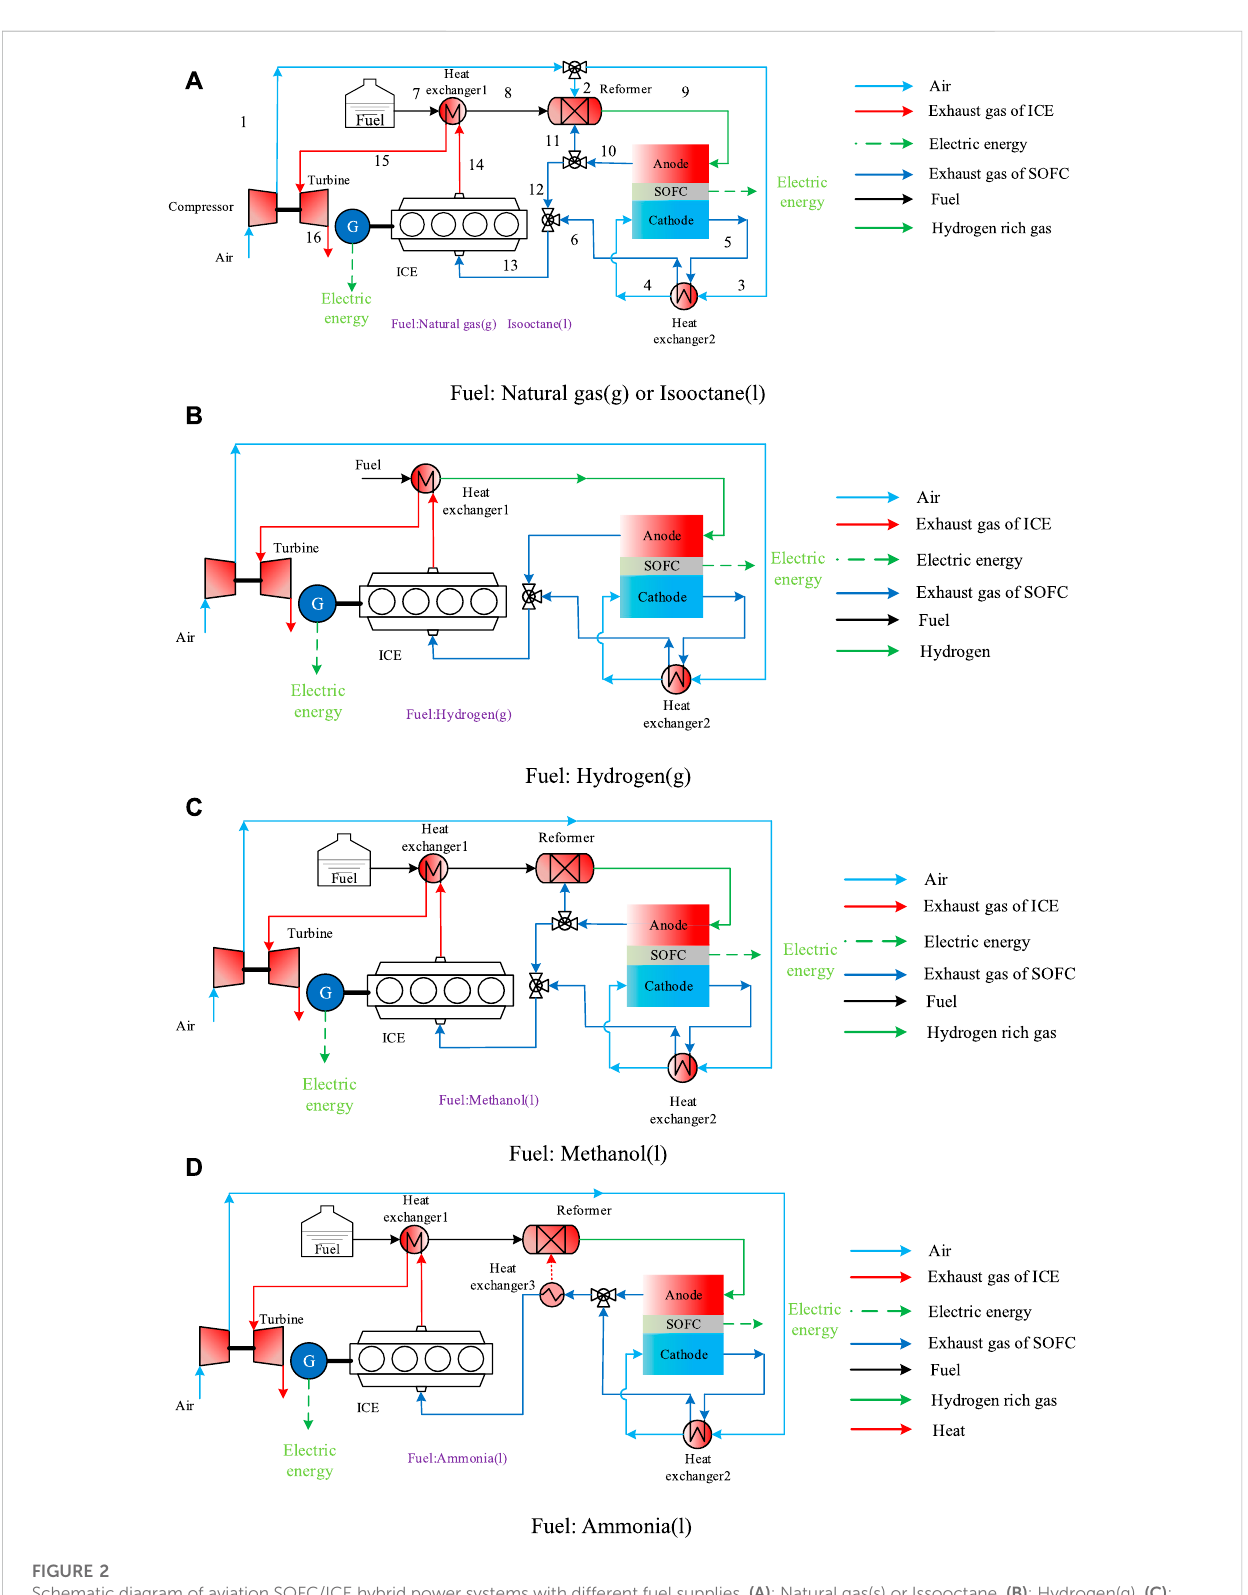
FIGURE 2 Schematic diagram of aviation SOFC/ICE hybrid power systems with different fuel supplies. (A) : Natural gas(s) or Issooctane. (B) : Hydrogen(g). (C) : Methanol(l). (D) :